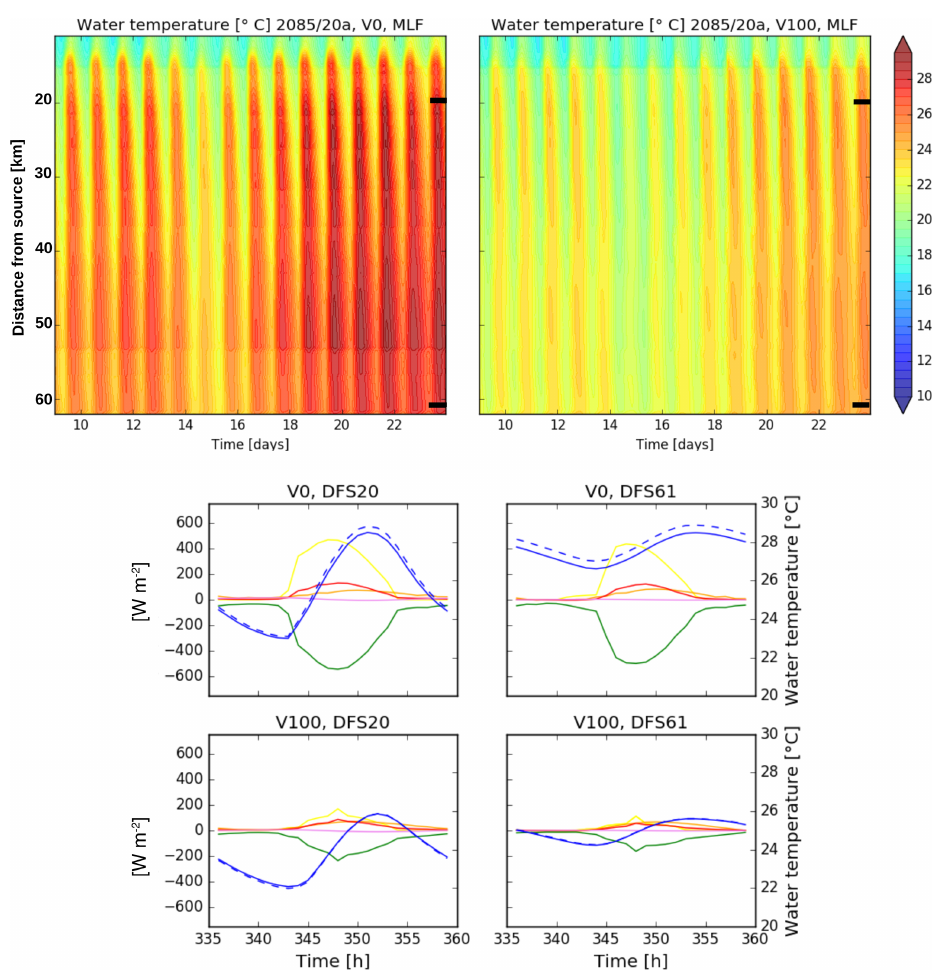
Figure 6. Upper panel: water temperature along the Pinka and the whole 20-year return period event centred on 2085 for no vegetation (V0) and full vegetation (V100). The black lines mark the location of the data shown below. Lower panel: the effect of a 15% discharge reduction (MLF of 15%) of the mean low flow conditions (blue, dashed) on stream temperature compared to MLF (blue, solid) and the diurnal amplitude of all energy fluxes (shortwave radiation balance is yellow, latent heat flux is green, longwave radiation balance is red, sensible heat flux is orange and conduction heat flux is violet) for an upstream (DFS 20km) location and a downstream (DFS 61km) location for the 20-year return period event centred on 2085 for no vegetation (V0) and maximum vegetation